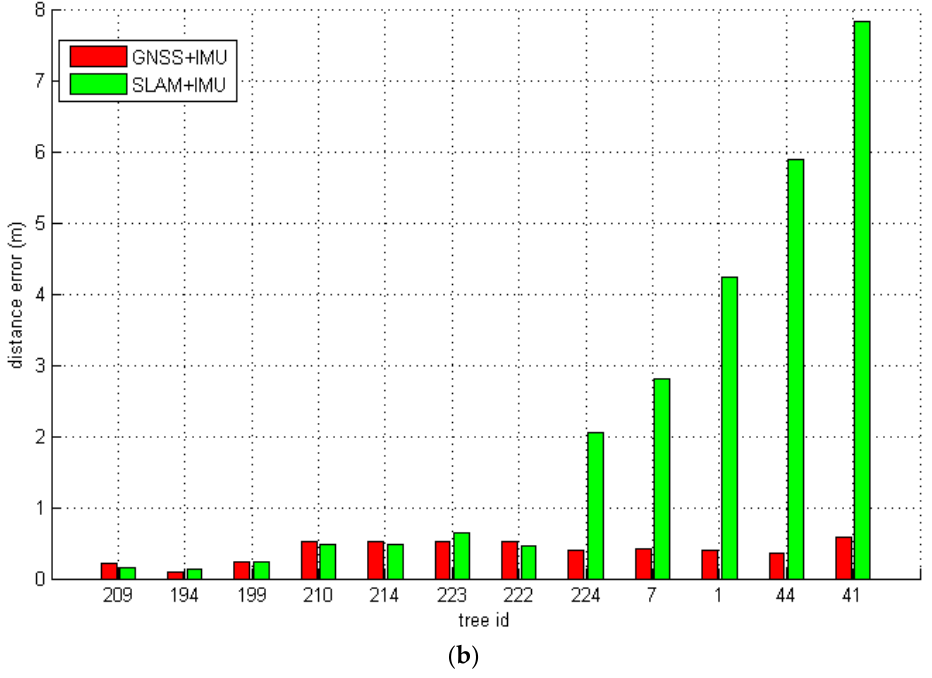
Figure 10. ( a ) Positioning errors of the SLAM + IMU solution in an open forest; ( b ) stem position errors along the trajectory between the GNSS + IMU and SLAM + IMU methods in an open forest environment. Table 3. The accuracy of the trajectory in a featureless area with 52 trees (Unit: m). Solution RMSE Easting RMSE Northing 2D GNSS + IMU 0.36 0.19 0.40 SLAM + IMU